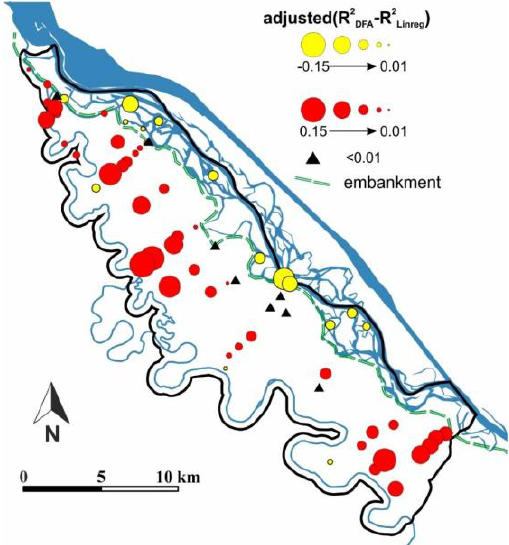
Figure 9. Better estimations were obtained in the floodplain area of the Danube using linear regression, a fact that can be explained by the very close linear connection between the wells and the river (typically r > 0.9). The phenomenon arises because only one background factor (i.e., the flow regime of the Danube) dominates the wells of the floodplain, so the delay with which the water level fluctuation can be observed is a more significant factor. Regression is capable of taking into account the temporal delay, a matter of some hours, with which the impact of the water level fluctuation of the river, may be observed in the well. In DFA it is not possible to include the time shift in the estimation of certain CTs. Latter is obtained from the time series of all the wells, while in the case of linear regression, the models were constructed well-by-well, based on the background factors. Water 2020 , 12 , x FOR PEER REVIEW